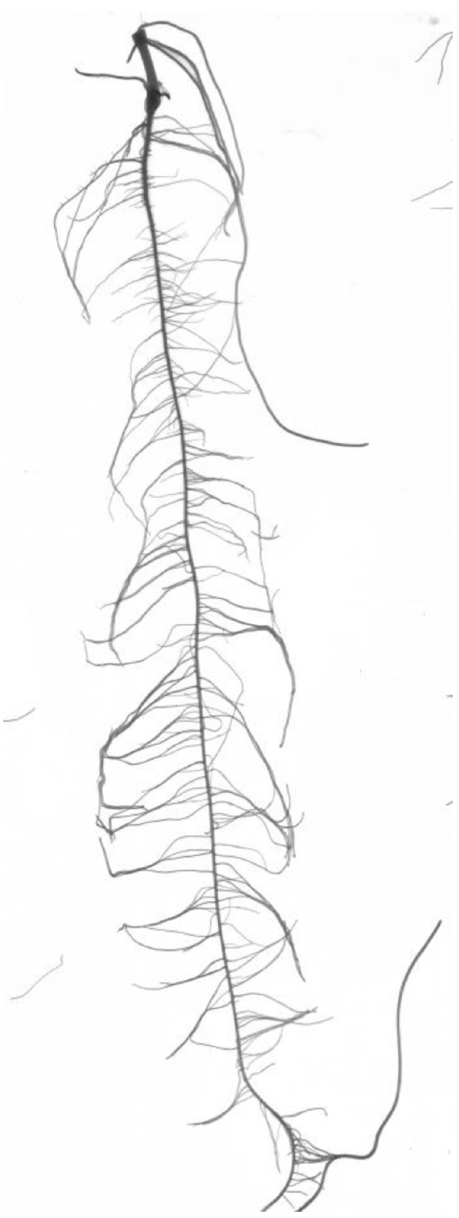
Figure 1. Image of a 14 day root.